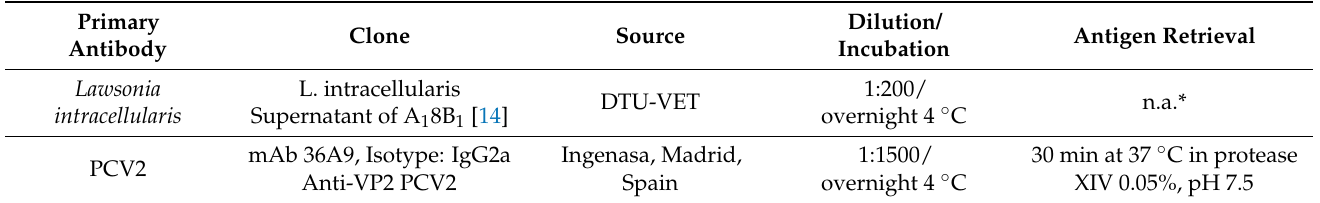
Table 2. Primary antibodies and operating conditions used for immunohistochemistry tests.